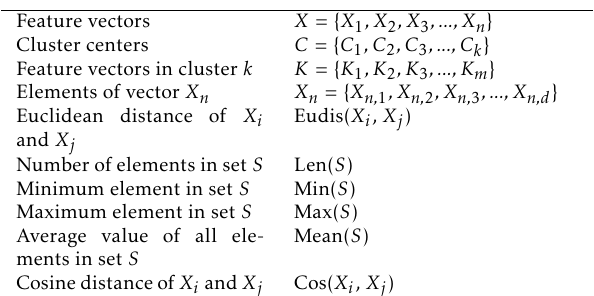
Table 1. Symbols used in the